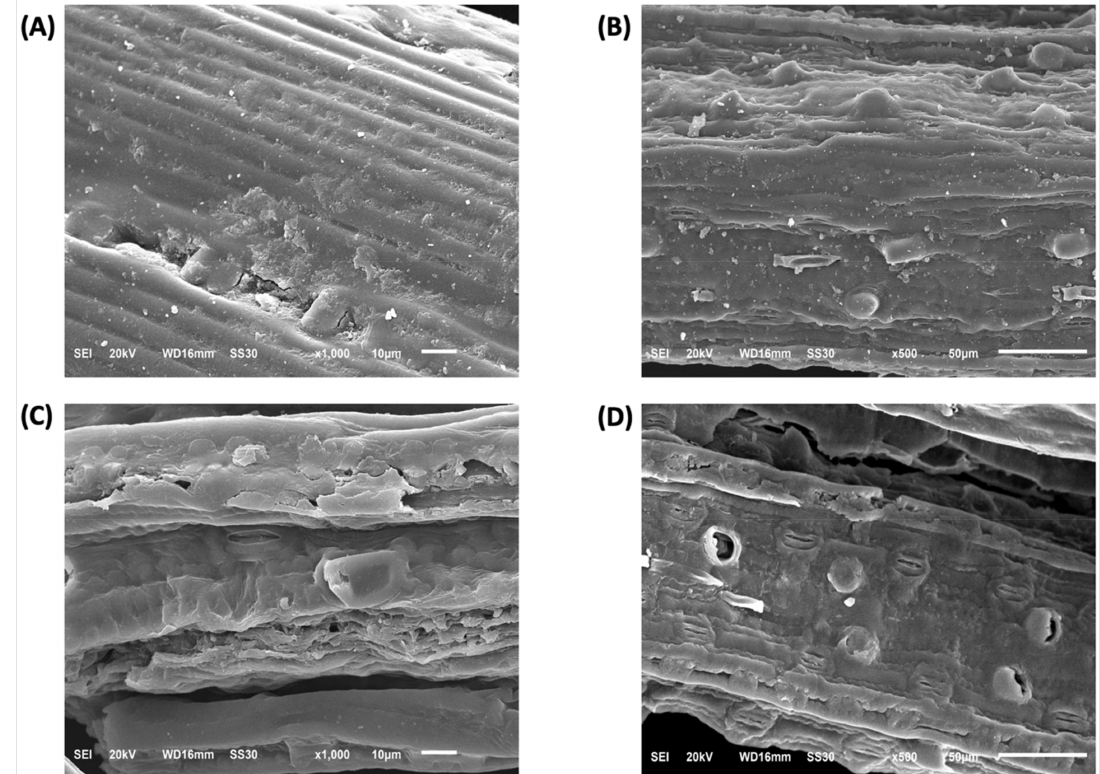
Figure 8. Scanning electron microscopy (SEM) images of ( A , B ) non-treated and ( C , D ) laccase pretreated P. maximum biomass.